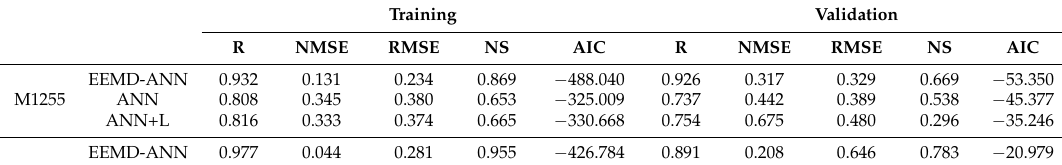
Table 1. Result of modeling from the ANN model at site M1255 and STL185.